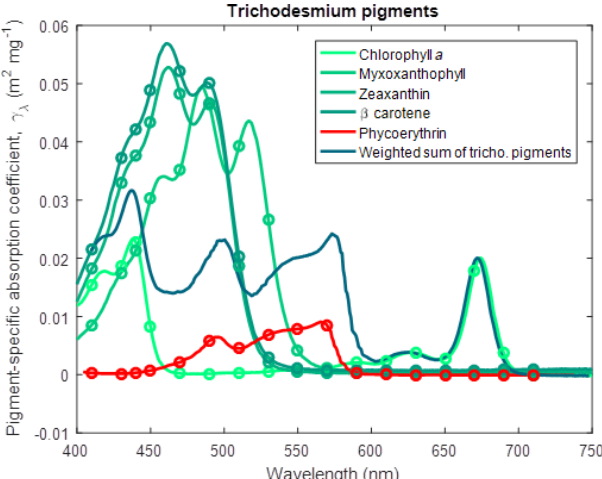
Figure 7. Pigment-specific absorption coefficients for the domi- nant pigments found in Trichodesmium determined using labora- tory standards in solvent in a 1cm vial. The aqua line represents the weighted sum of the photosynthetic pigments (Eq. 5), with the weighting calculated from the ratio of each pigment concentration to chlorophyll a . See Fig. 5 for more details. Myxoxanthophyll was dissolved in